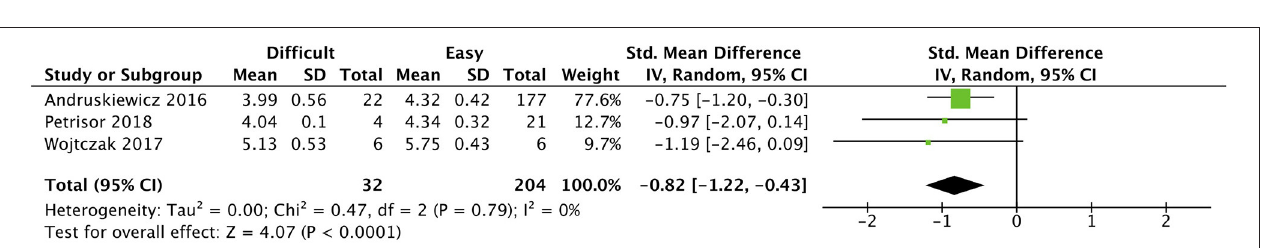
FIGURE 7 | Skin to anterior aspect of the trachea distance at the level of suprasternal notch forest plot comparing difficult and easy laryngoscopy groups.